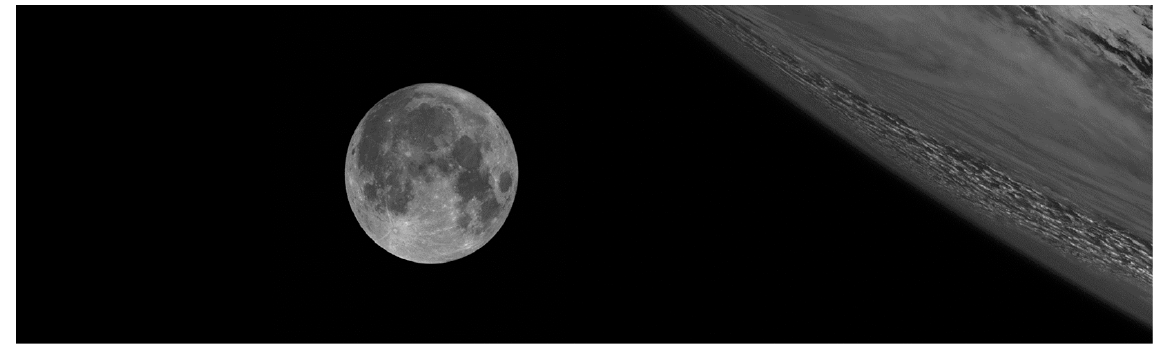
Figure 7. An AMI image of the Moon and portion of the Earth observed by GK2A AMI on 9 September 2019 in VI006 channel (0.64 µm).